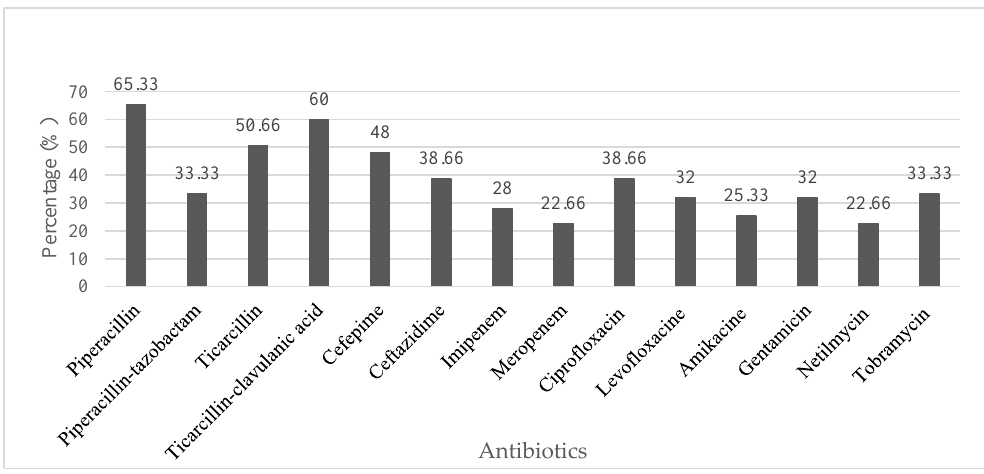
Figure 2. Antibiotic resistance of Pseudomonas aeruginosa.